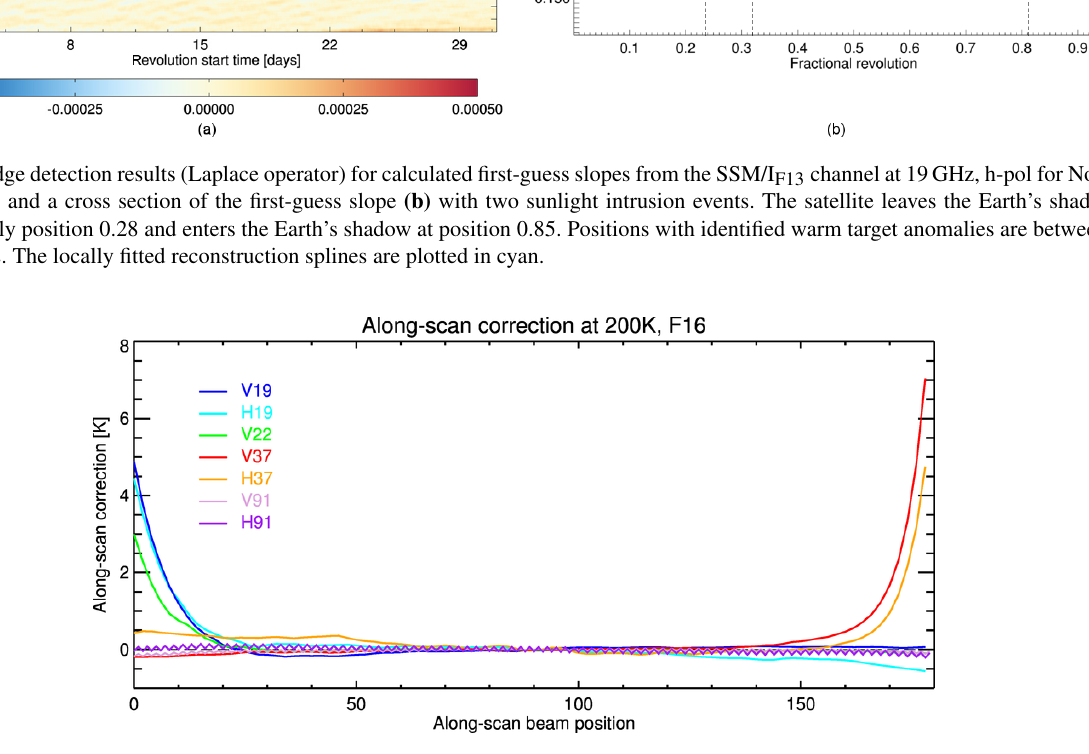
Figure 5. Along-scan correction for SSMIS F16 . The image shows the along-scan correction applied to a scene temperature of 200K. Colours are as follows: blue – v19; cyan – h19; green – v22; red – v37; orange – h37; plum – v91; violet –